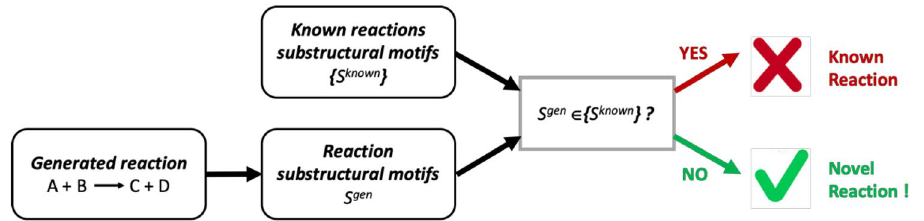
Figure 4. Reactions novelty detection workflow. Substructural motifs S gen ( RC , RC + 1 , RC + 2, …) are extracted from the query CGR and compared with those for known reactions { S known }. In such a way, motifs belonging to novel reactions will easily be identified.